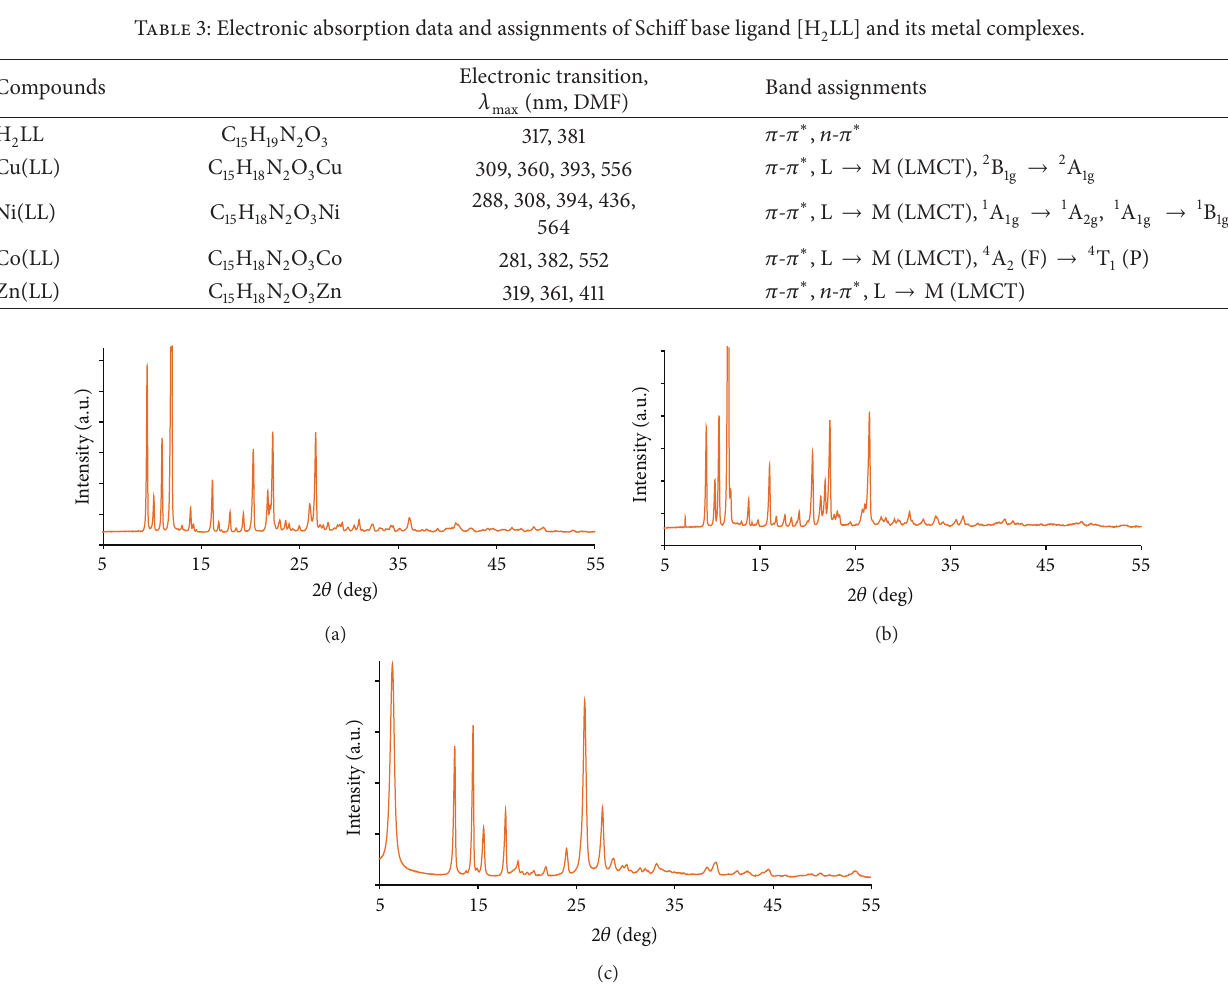
Figure 4: Powder XRD pattern of the (a) Cu(II), (b) Ni(II), and (c) Zn(II)